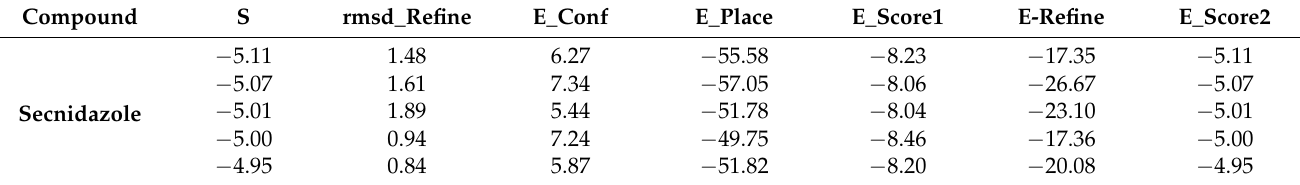
Table 11. Docking score and energy of the compounds and 3hb5 breast cancer